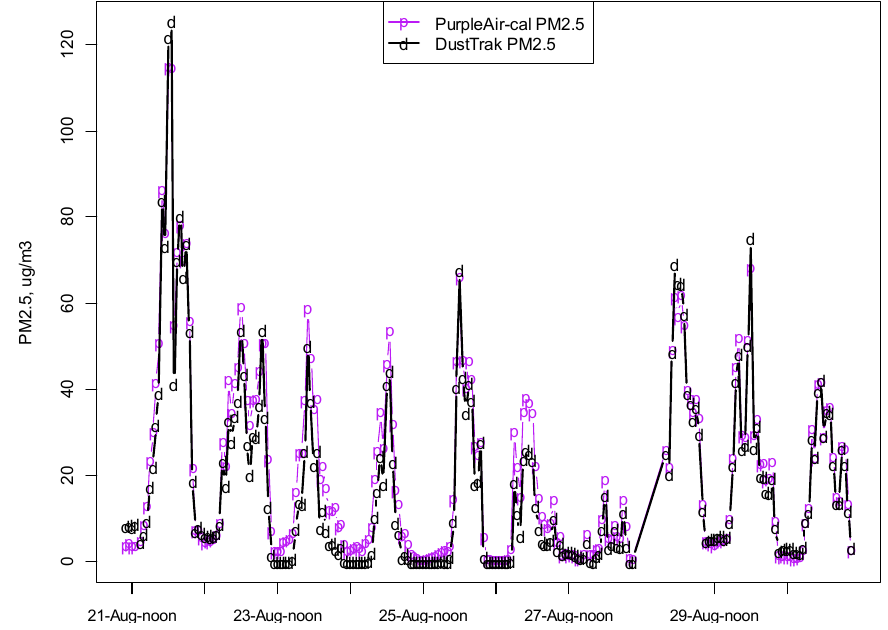
Figure 4. Comparison of calibrated PurpleAir PM 2.5 and the Armidale Regional Council DustTrak measurements, 21 August to 1 September 2017.